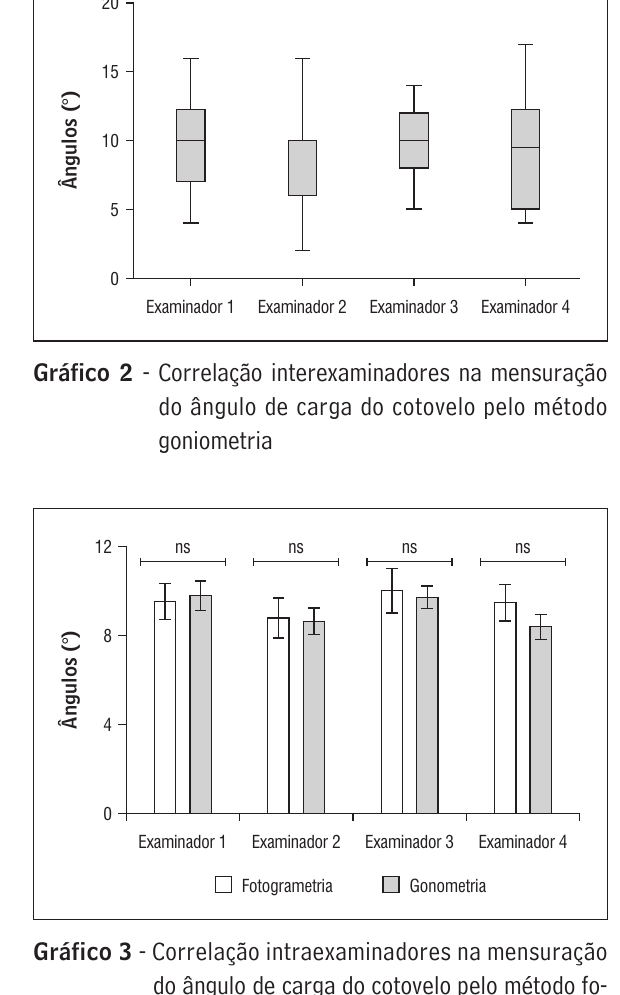
Legenda: *ns = não signi fi cativo (nível de signi fi cância de alfa <